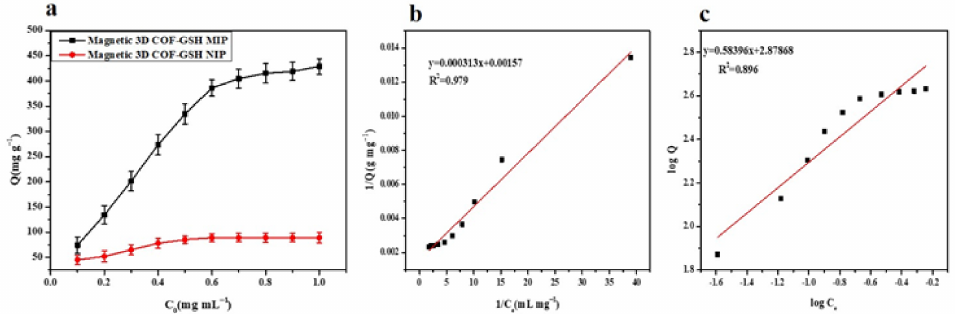
Figure 4. ( a ) Curves of adsorption isotherms of magnetic 3D COF–GSH MIPs and NIPs. ( b ) Adsorp-